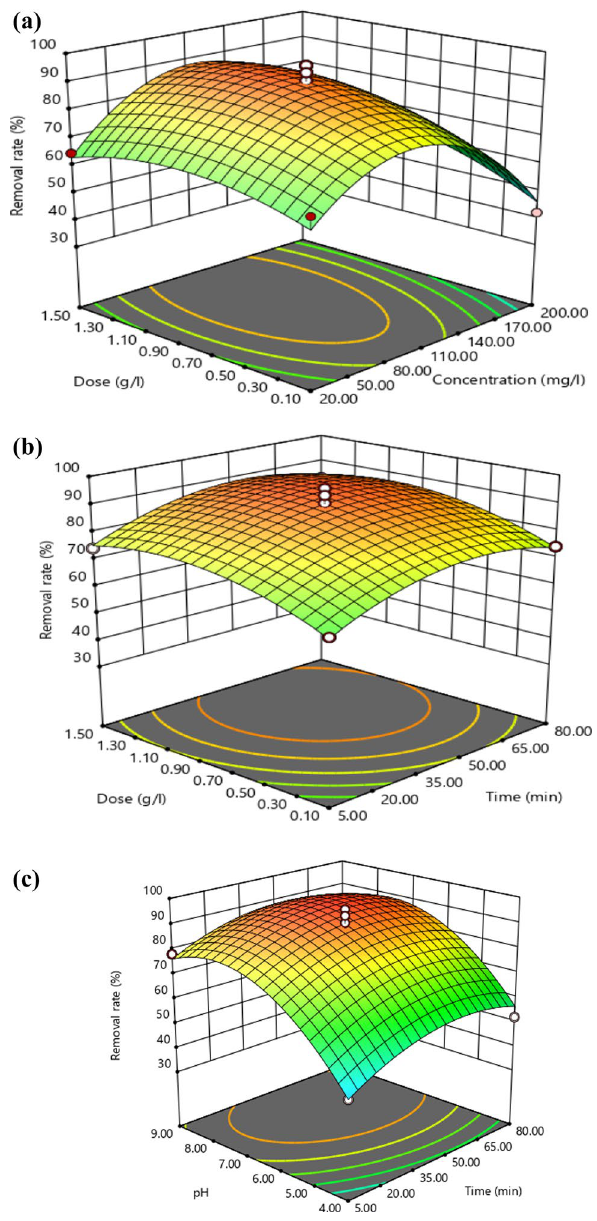
Fig. 6 Response surface plot about the effects of a pH vs. time, b S. platensis vs. time and c S. platensis vs.